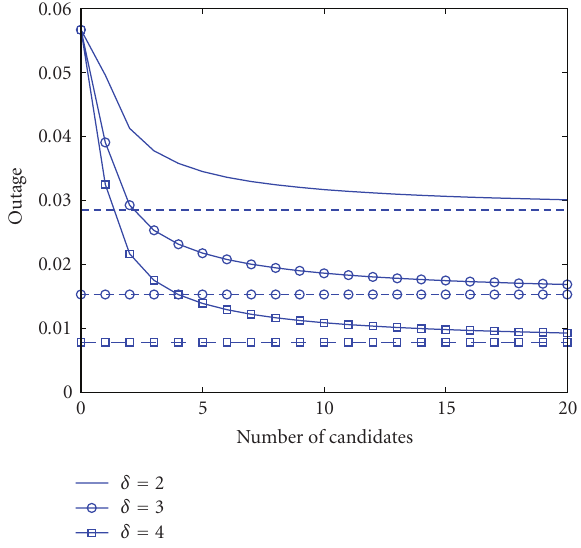
Figure 8: Outage of single-relay selection system with up to 20 candidate